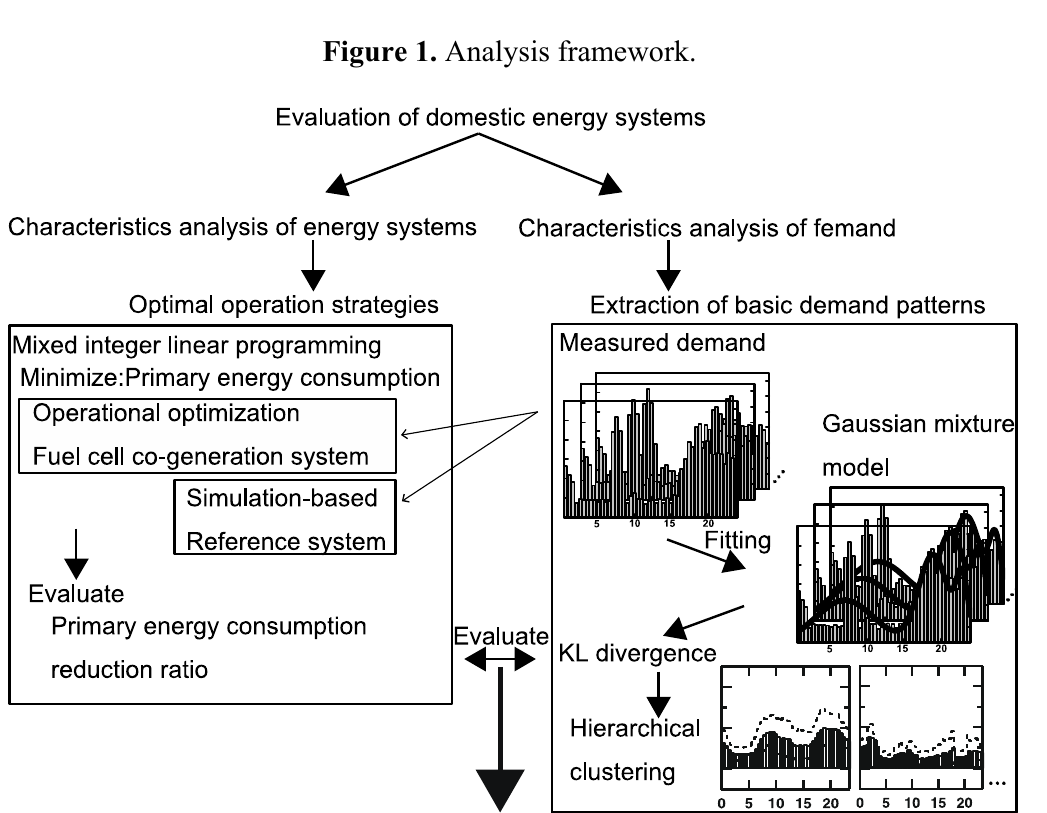
Figure 1. Analysis